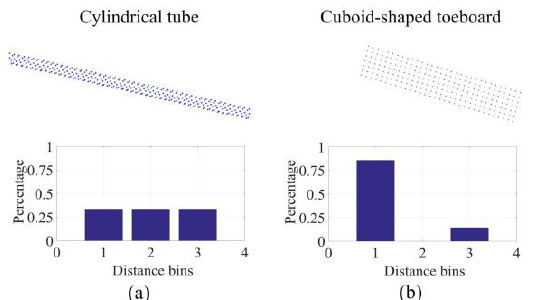
Figure 6. Two examples of simulated point cloud and accumulated histograms. a) Tube. b)